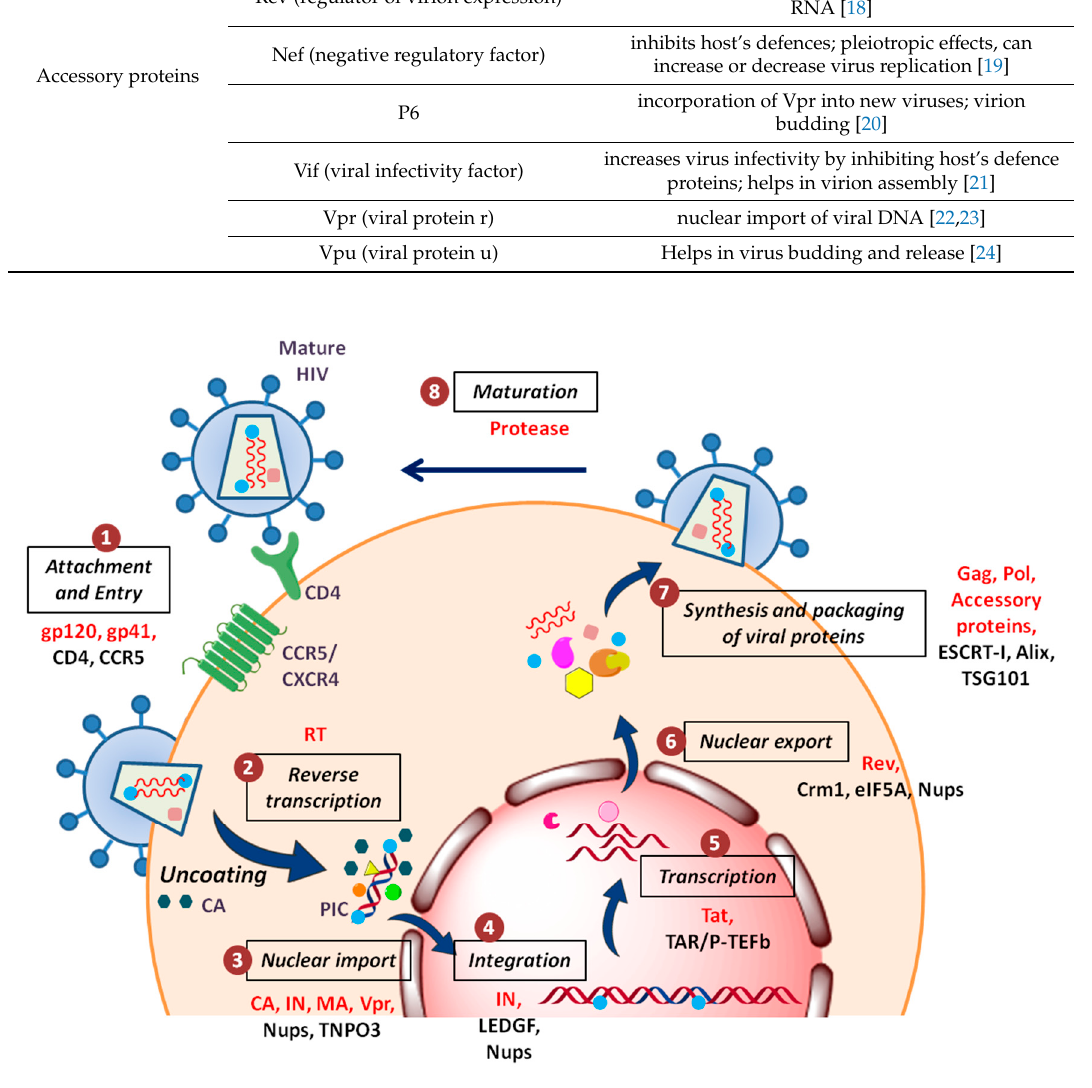
Figure 1. Schematic overview of the HIV-1 replication cycle: (1) The HIV-1 particle attaches and fuses itself to the host cell membrane via its surface glycoproteins and enters the cell cytoplasm; (2) viral genomic RNA is reverse transcribed into DNA, accompanied by uncoating of the viral capsid; (3) nuclear entry of pre-integration complex occurs with the help of various host nuclear proteins; (4) integration of vDNA into the host chromatin; (5) during productive infection, viral transcription takes place; (6) RNA splicing and nuclear export of viral RNA occurs; (7) production and assembly of new virus particles, which bud from the plasma membrane; and (8) virions become infectious after maturation (action of protease). The viral and host cellular proteins involved in the replication cycle of HIV-1 are highlighted at each step in red and black,